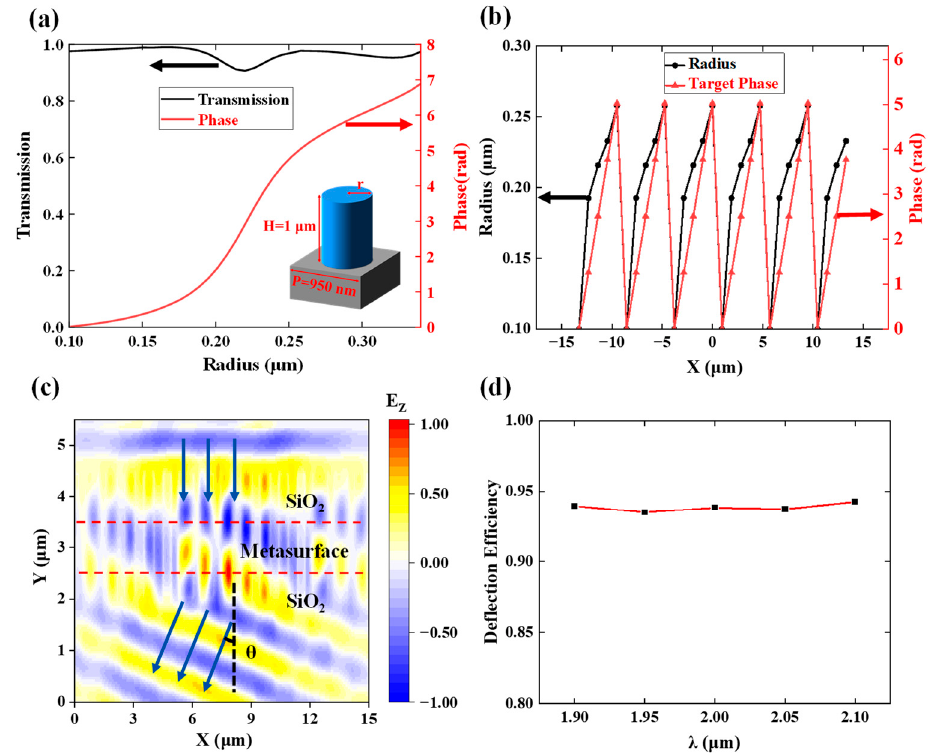
Figure 3. ( a ) Transmission and phase of the periodic a − Si pillars with 950 nm unit cell size and 1 µ m height for different radii. ( b ) The relationship between the target phase and target radius with position ( c ) The Ez field propagation at the wavelength of 2 µ m (the arrows mark the direction of light). ( d ) The transmission of meta-deflector at the 1.9~2.1 µ m band.